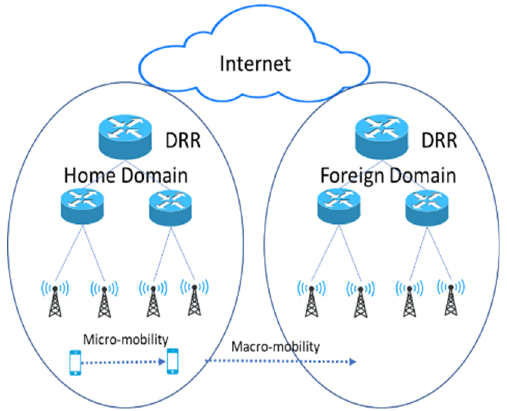
Figure 6. Handoff-Aware Wireless Access Internet Infrastructure (HAWAII) hierarchy based on domains.